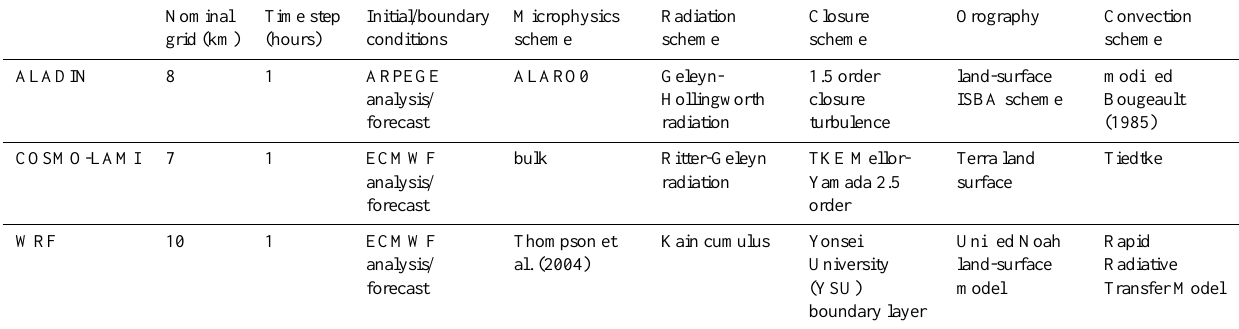
Table 1. LAMs set-up. Nominal Time step Initial / boundary Microphysics